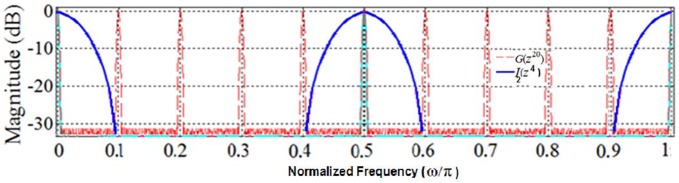
Magnitude responses of IFIR components of U(z): G(z20) and I2(z4).